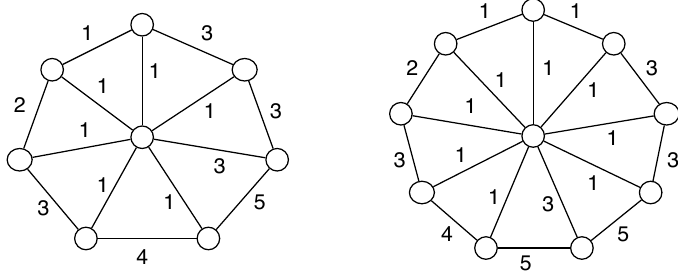
-antimagic labelings of W k